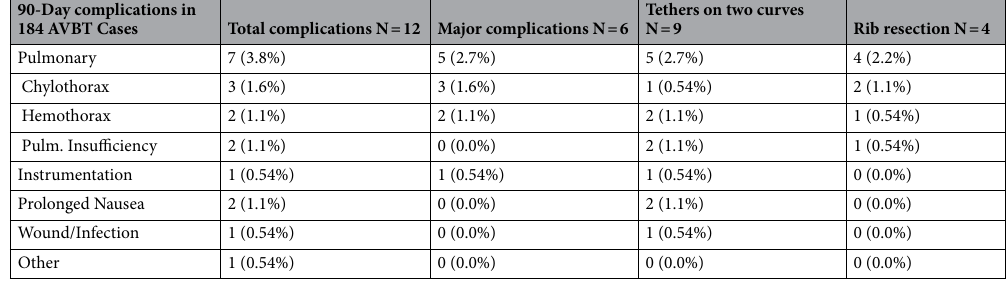
Table 2. Complication